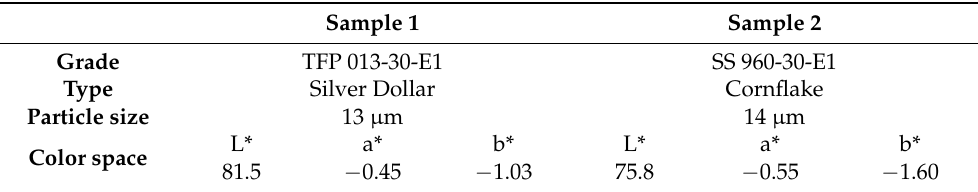
Table 3. Comparison of color spaces depending on aluminum flake